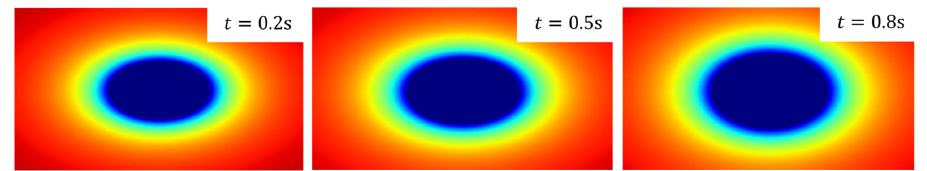
Figure 6. Distribution of target attraction field over time.